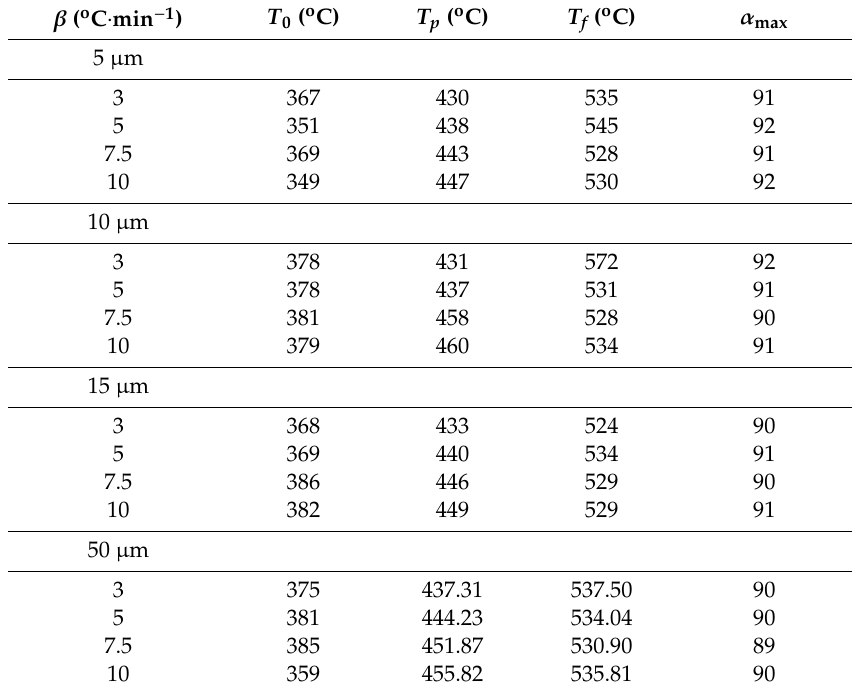
Figure 2. Differential thermogravimetry (DTG) rofiles of polystyrene pyrolysis in nitrogen atmosphere at 3 K·min −1 for 5, 10, 15, and 50 µm particle sizes. Table 2. Characteristic temperature T 0 , T p and T f for polystyrene pyrolysis determined from thermogravimetric analysis (TGA) profiles at different heating rates.